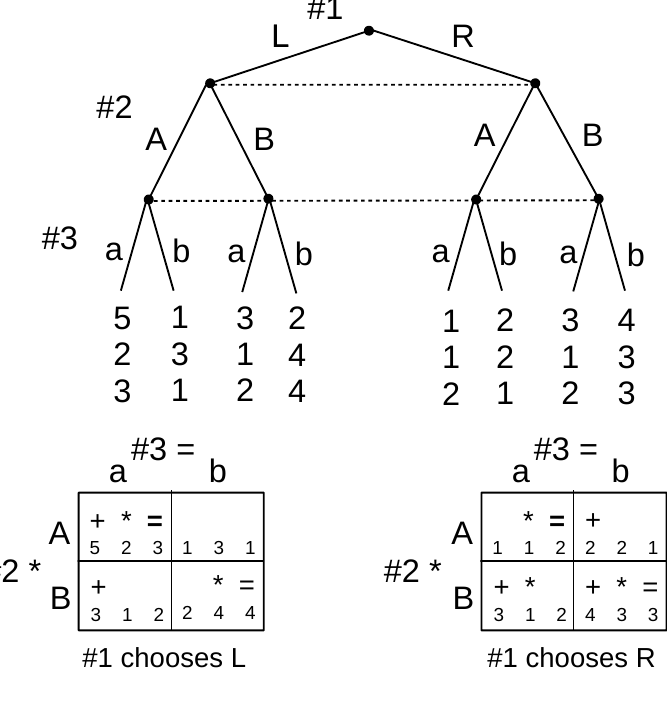
Figure 7. Three-player